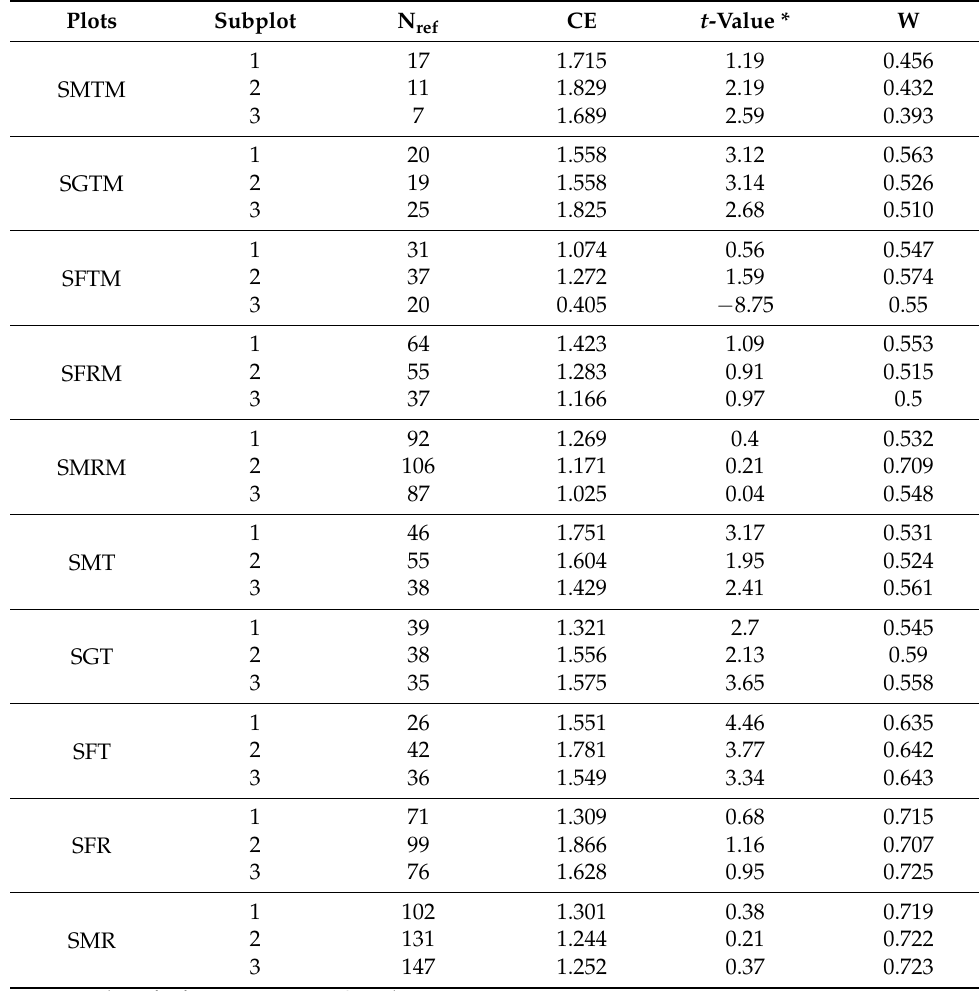
Table 3. Horizontal structure indices in the 15 m-radius subplot.